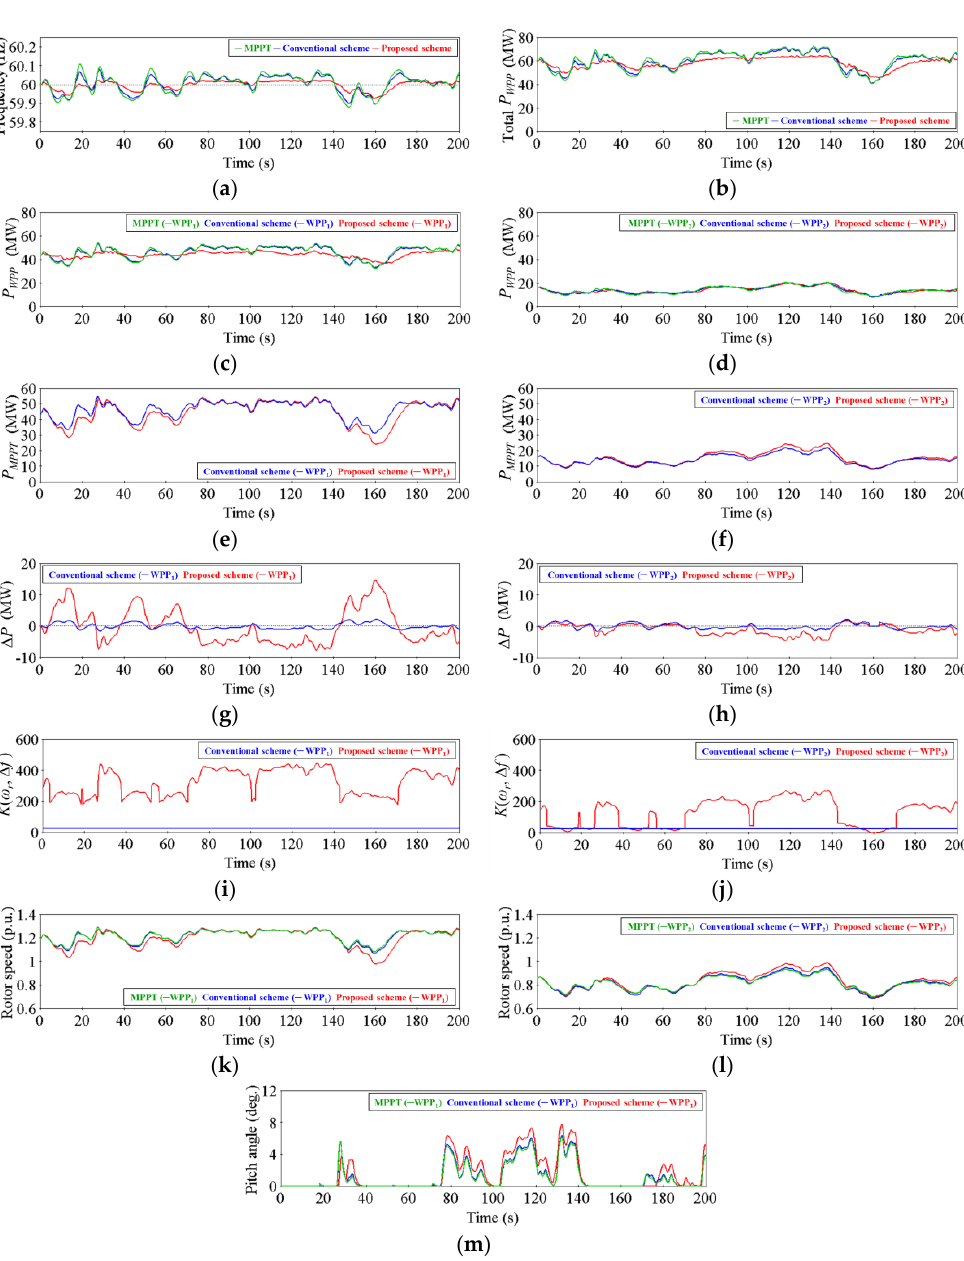
Figure 7. Results for Case 1. ( a ) Frequency; ( b ) Total output power of two WPPs; ( c ) Output power